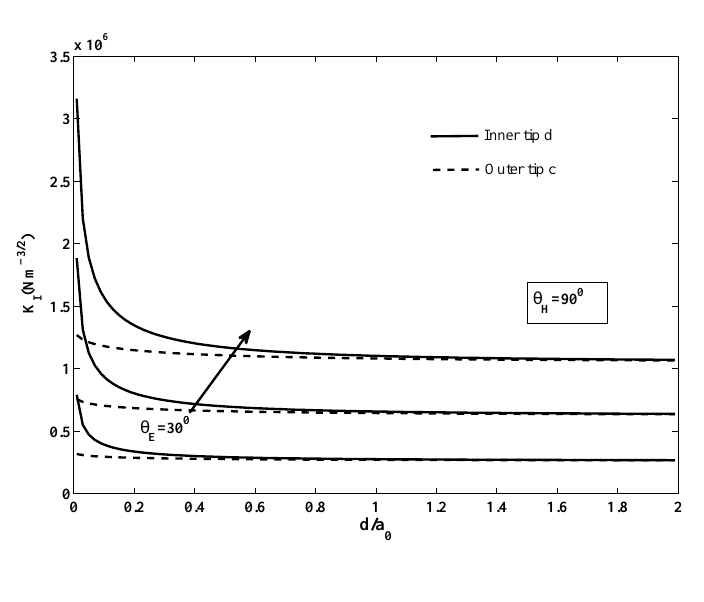
Fig. 4 SIF versus inter-crack distance for different electric poling with fixed magnetic poling